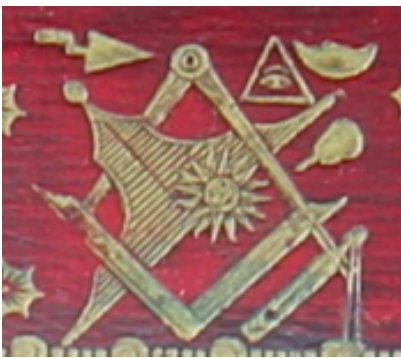
Fig. 12d. Constitutions 1784 . Copyright and reproduced by permission of the Museum of Freemasonry, London. L2452.